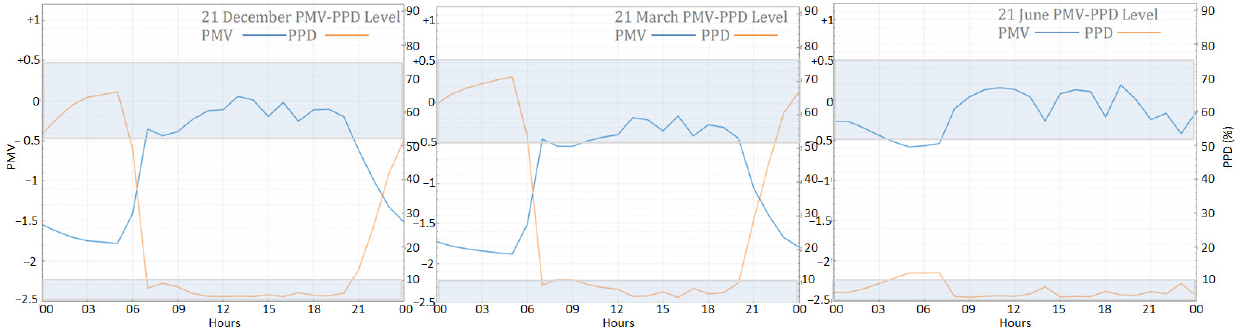
Figure 8. PMV-PPD results of the base mosque scenario on the selected days.